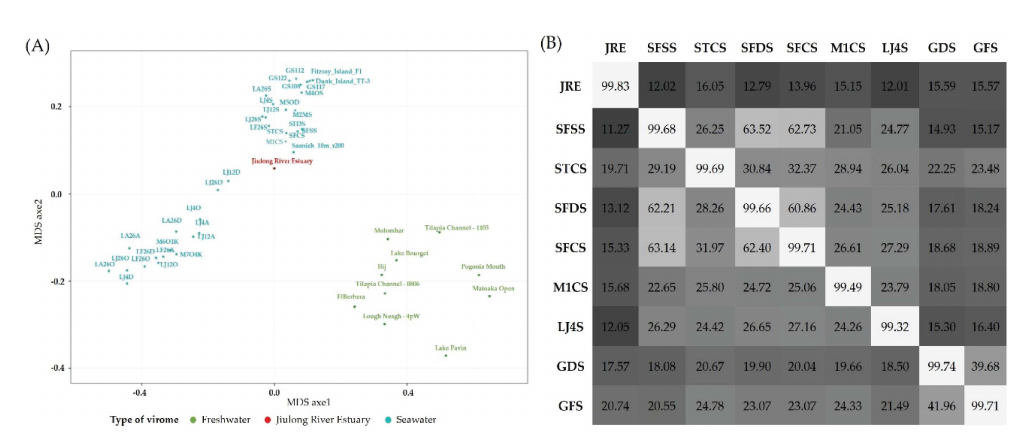
Figure 6. ( A ) MDS plots of freshwater (green) and marine (cyan) publicly available viromes with the JRE virome (red) using Metavir; ( B ) Coarse-grain genetic overlap between the JRE virome and PCSVs. The heat-plot represents the results of cross-tblastx comparisons between samples. Values (% of total reads with hits) with E -value ď 10 ´ 3 are labeled within the boxes. Horizontal labels represent viromes acting as query, and vertical labels represent viromes acting as